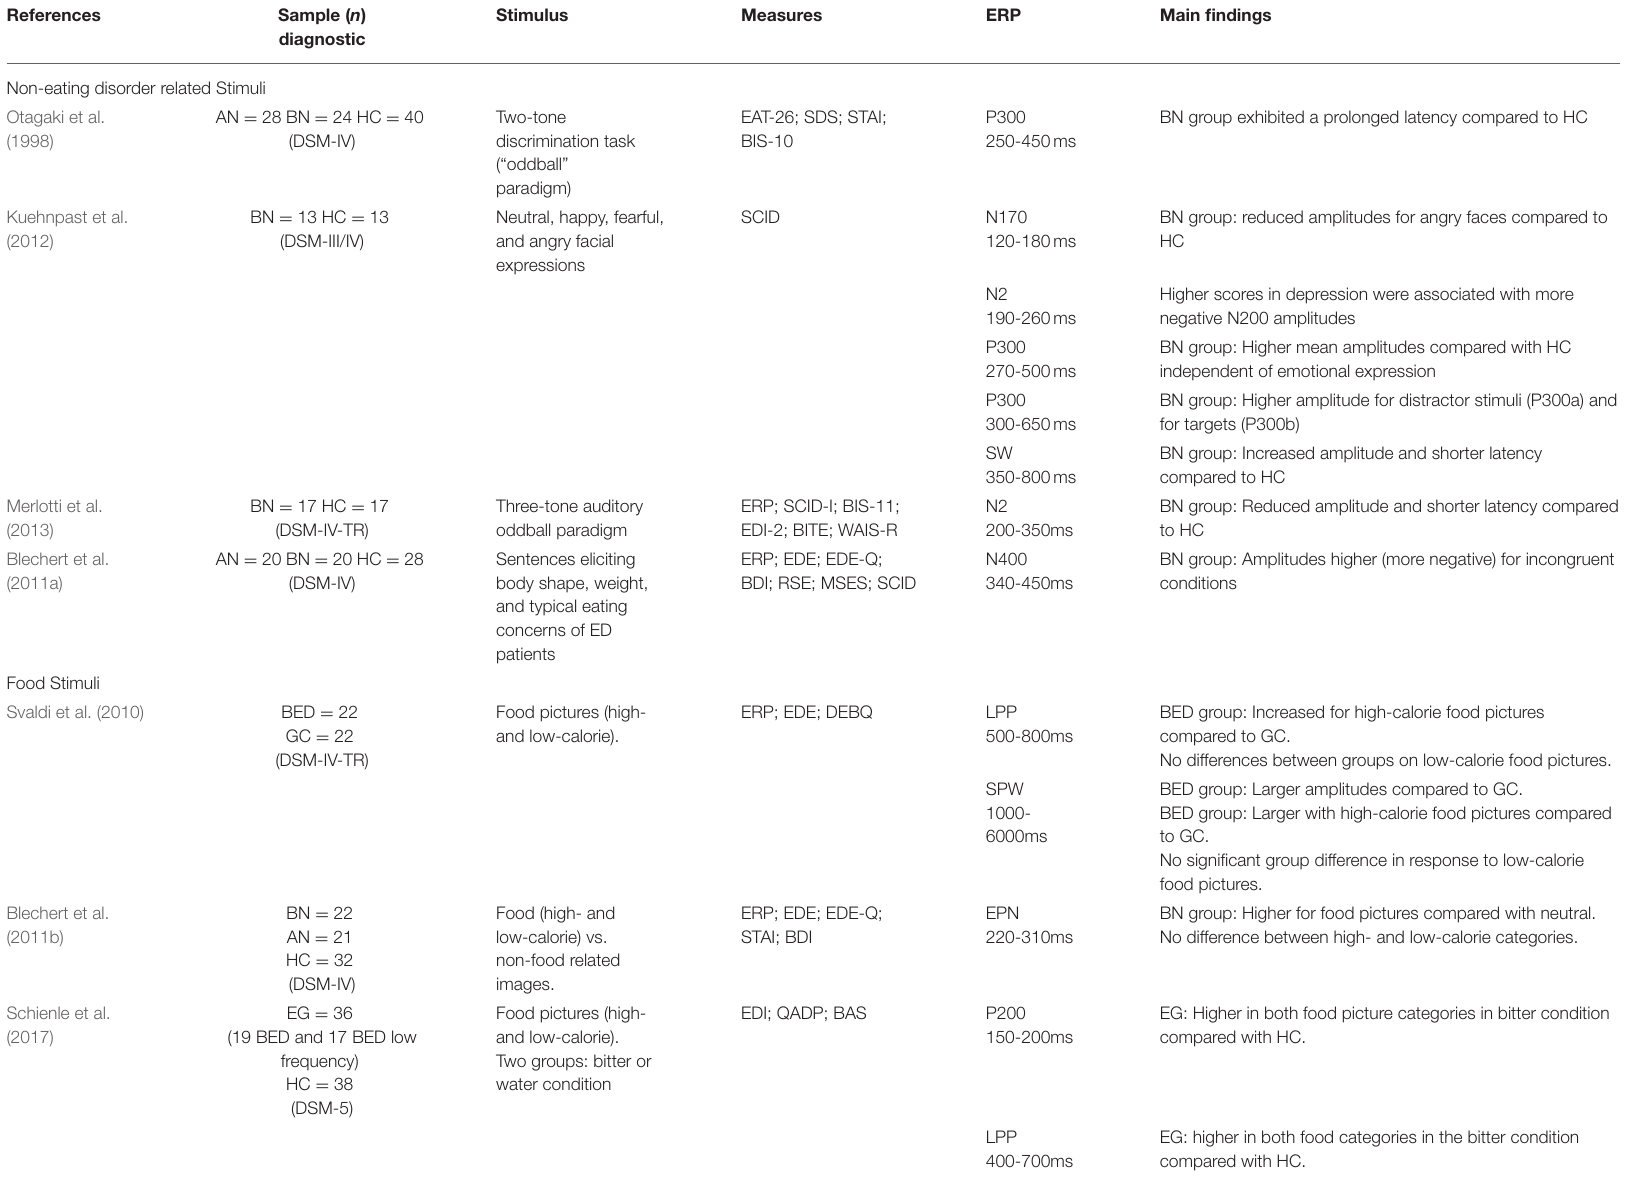
TABLE 3 | Time domain analysis: studies evaluating ERP waveforms in